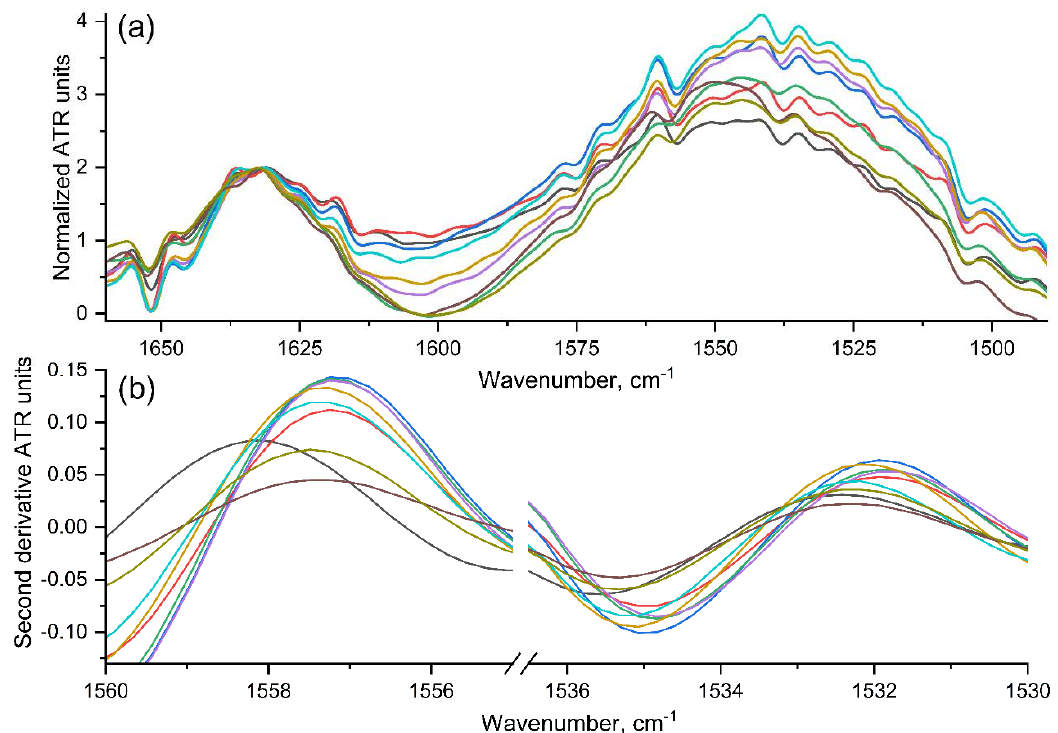
Figure 4. ( a ) Normalized to the amide I band Fourier transform infrared spectra of ConA: titration of ConA by ligand HPCD-spermine-Man- 1 . The sequential addition of the ligand corresponds to the transition from blue to red and black, i.e., from top to bottom. ( b ) Amide II areas in differential IR spectra of the second order. C 0 (ConA) = 33 μ M. Ligand concentration varied from 90 to 750 μ M. Natrium-citric buffer solution (0.04 M, pH 5.5). C(Ca 2+ ) = C(Mn 2+ ) = 1 mM. T = 22 °C.